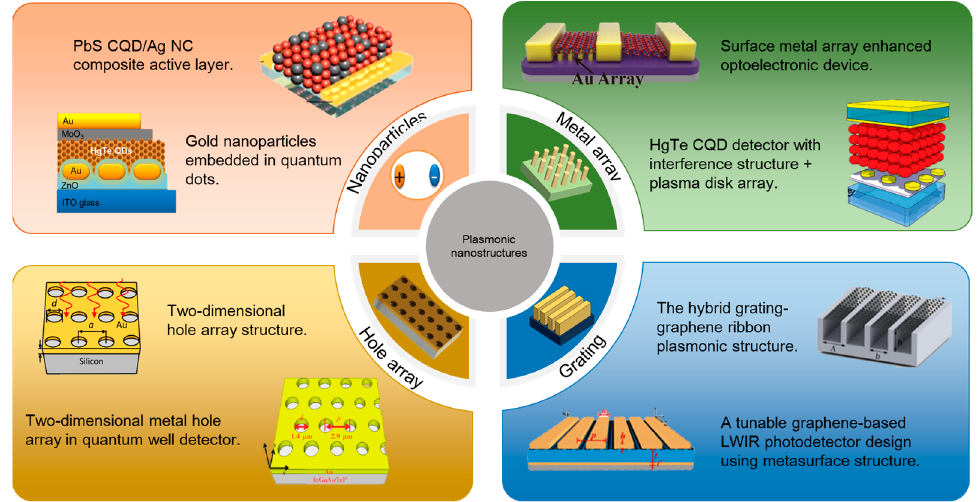
Figure 2. Progress in plasmonic enhanced infrared PDs. These four parts represent infrared PDs based on different plasmon-enhanced structures, namely nanoparticles, metal grating, hole array and metal array.